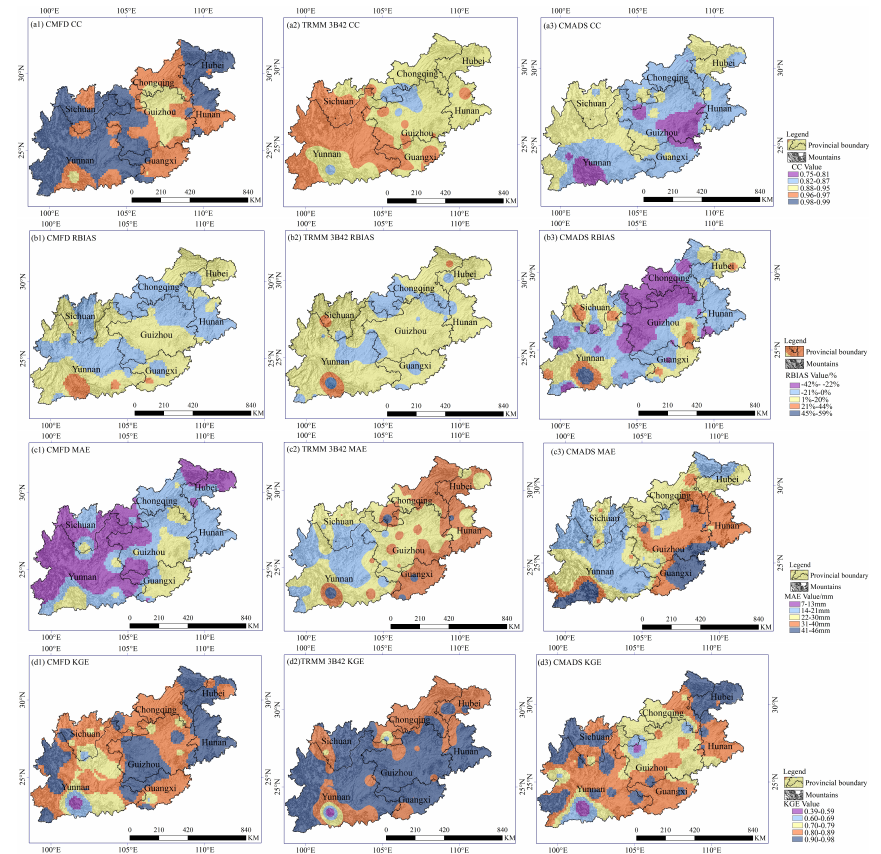
Figure 10. Distribution of the statistical